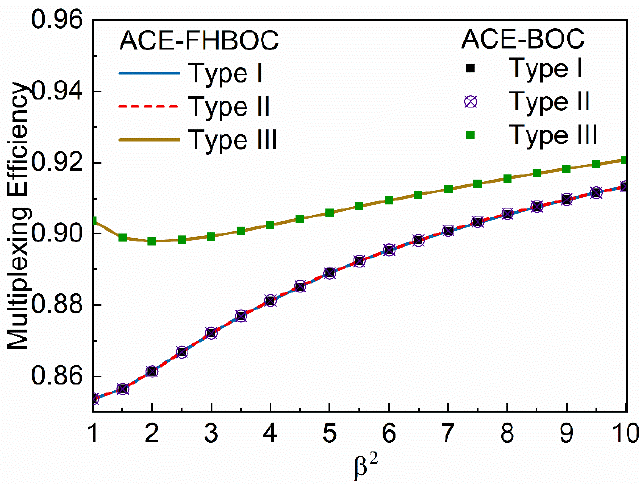
Figure 12. Multiplexing efficiency of Type-I, -II, and –III ACE-FHBOC and ACE-BOC.